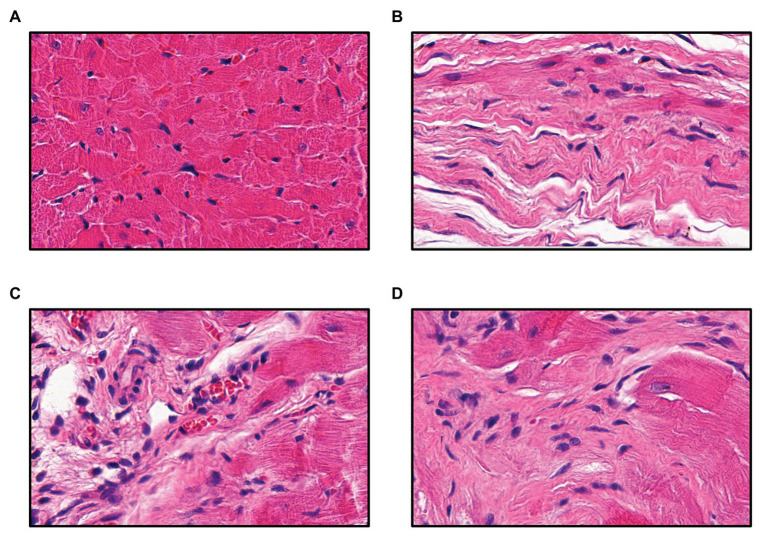
Left ventricular myocardial cell structure (HE staining 40 × 10 times). (A) Sham operation group; (B) control group; (C) sodium creatine phosphate group; and (D) Xinmailong group.